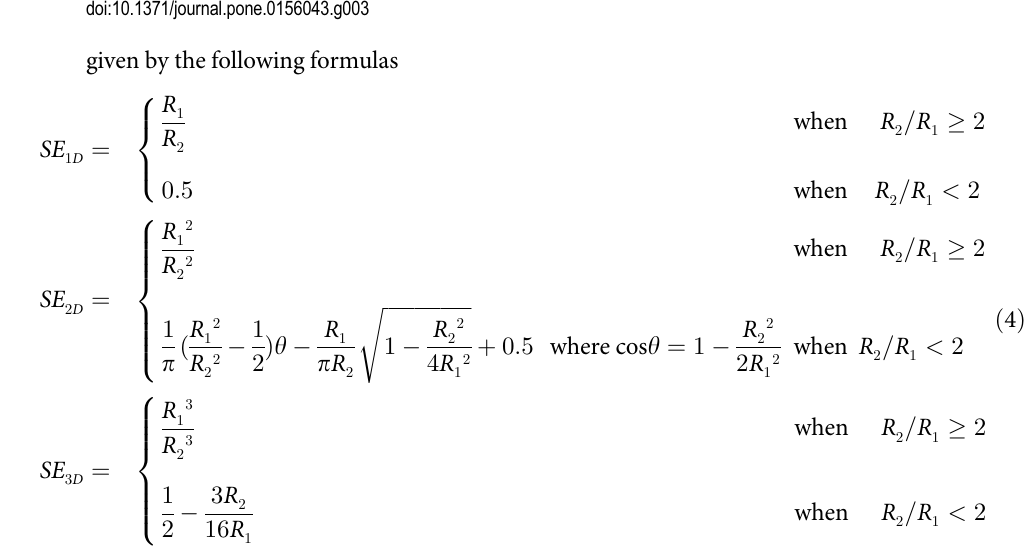
Fig 3. Two-dimensional (2-D) schematic plot for calculating hypothetical sampling efficiency from the initial (I) toward the target (T) structures.